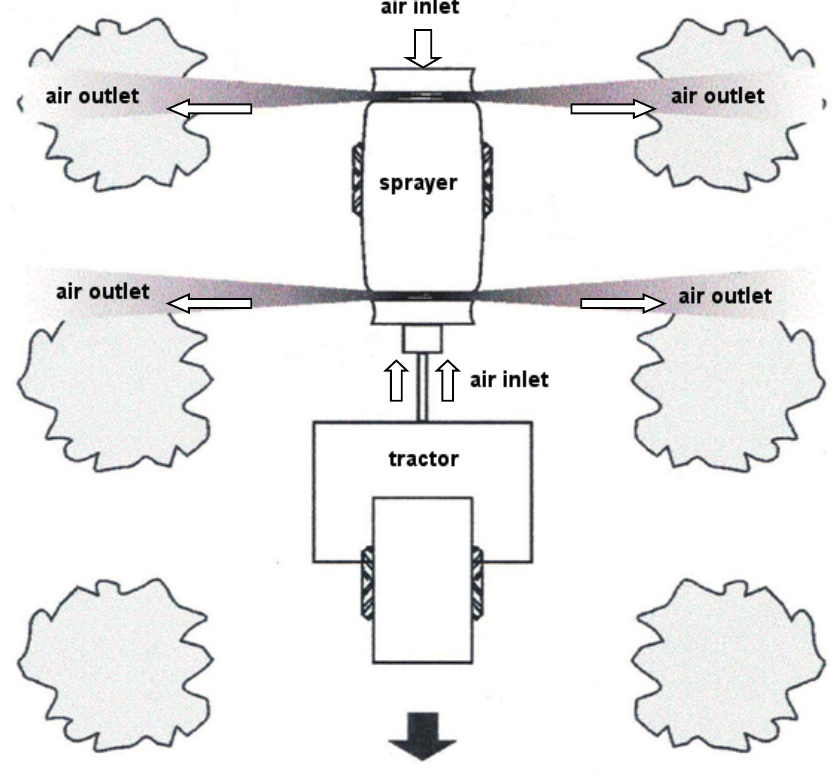
Figure 2. Air flow produced by the front and back